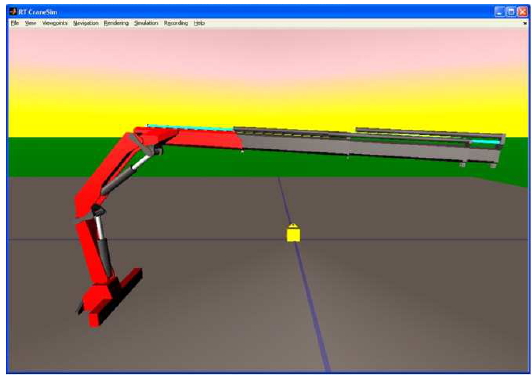
Figure 12: Example of the 3D animation.